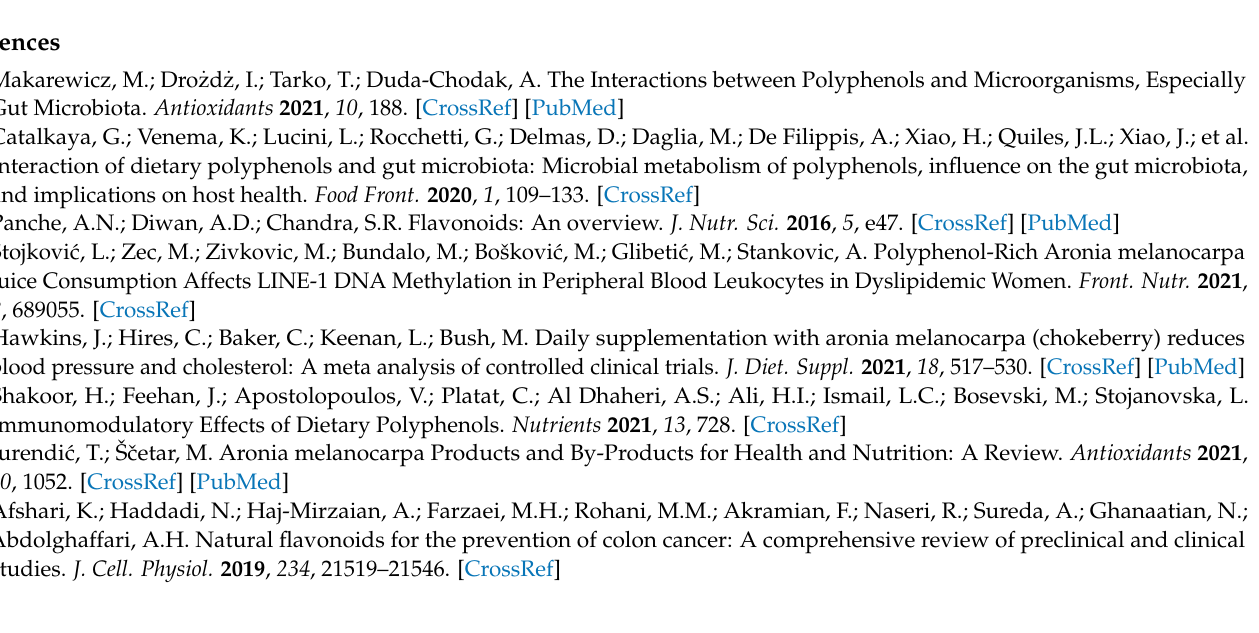
Figure S2: Progression of Vitamin C plasma levels; Figure S3: Representative flow cytometry plots from the Treg differentiation experiments; Table S1: Nutrient profile of the study cohort at baseline; Table S2: Concentrations of